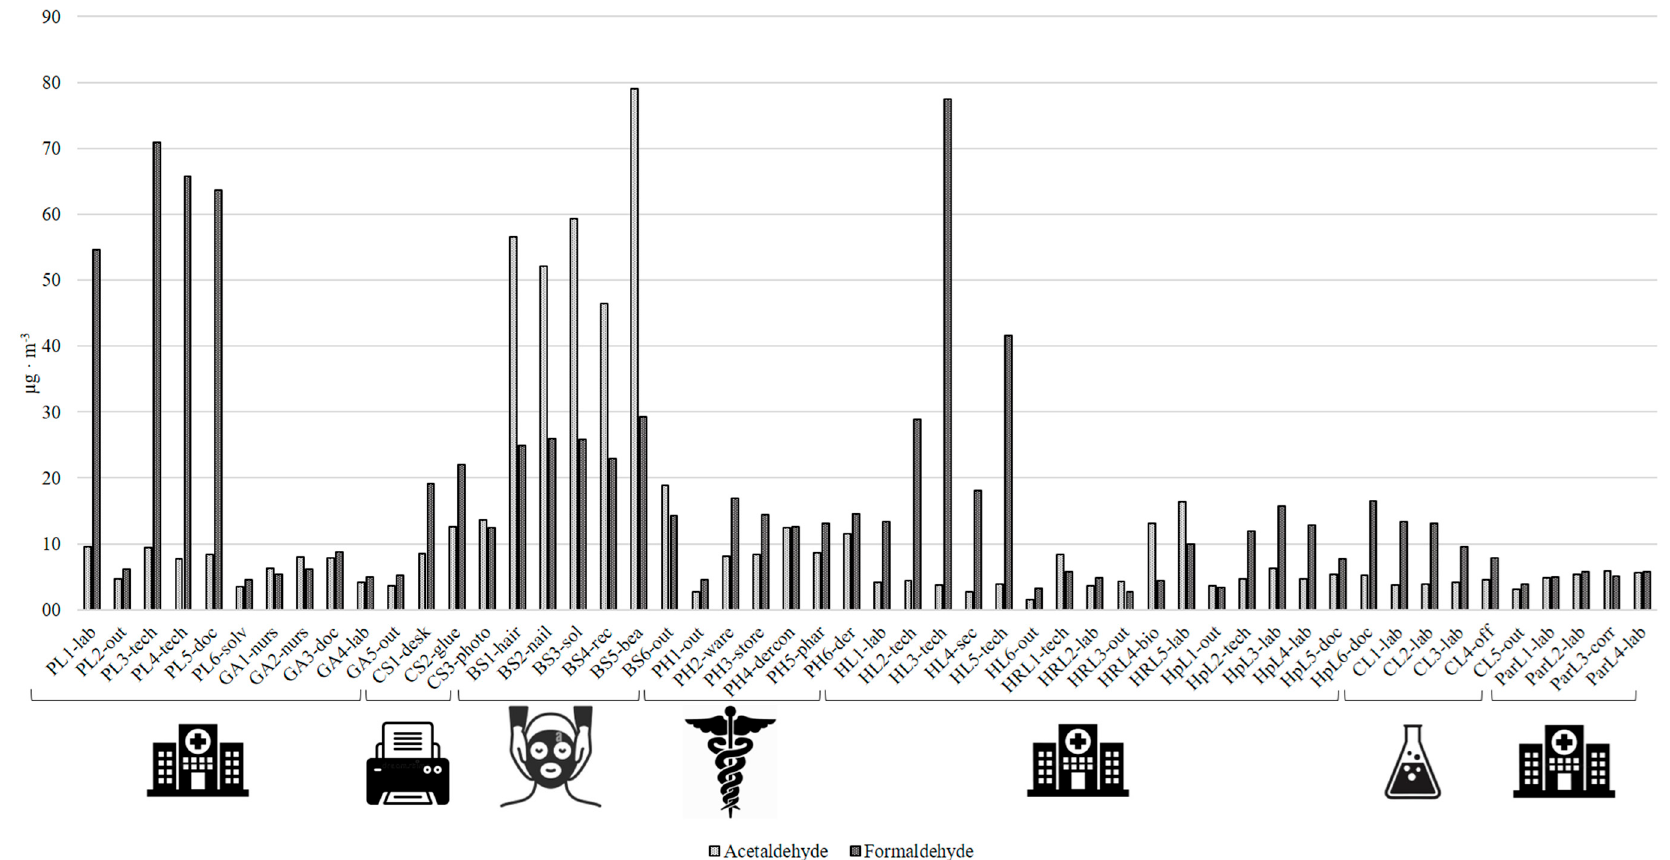
Figure 1. Distribution (concentrations expressed as µg m − 3 ) of formaldehyde and acetaldehyde in the previously described work environments.